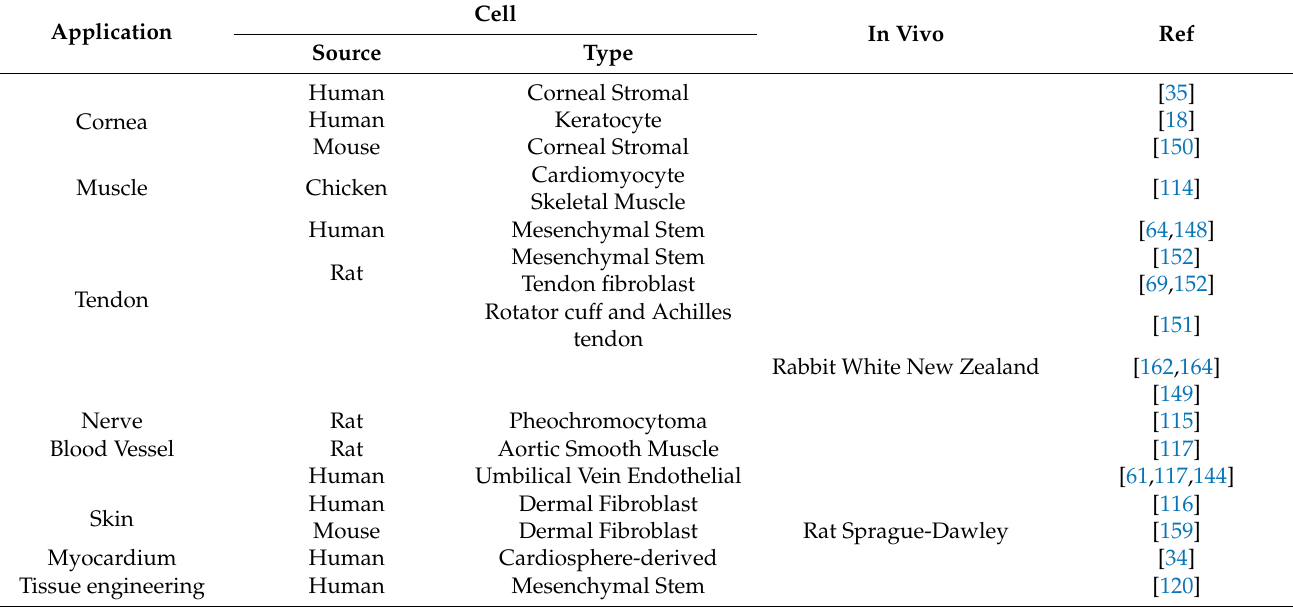
Table 8. Summary of electro-compacted collagen scaffold